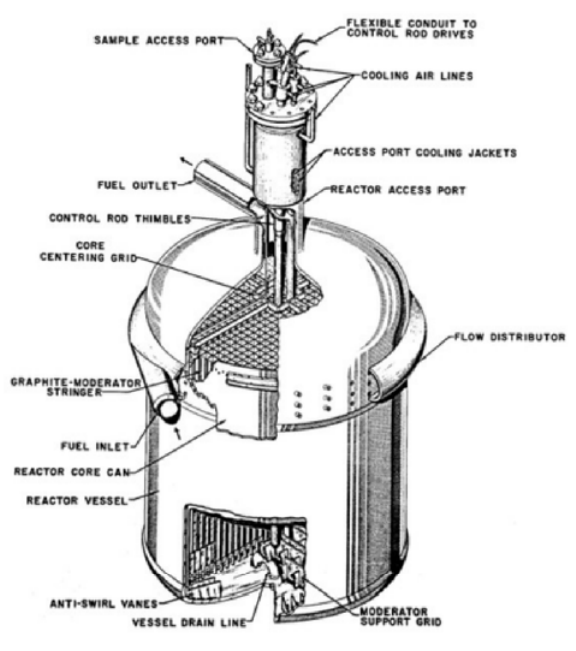
Figure 1: Diagram of MSRE core